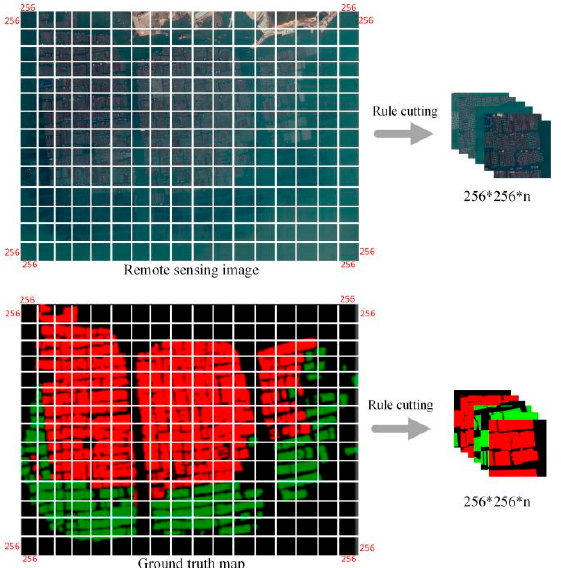
Figure 1. Image clipping. Each remote sensing image and corresponding label are cut into the same × number of samples of the same size (256 × 256). number of samples of the same size (256